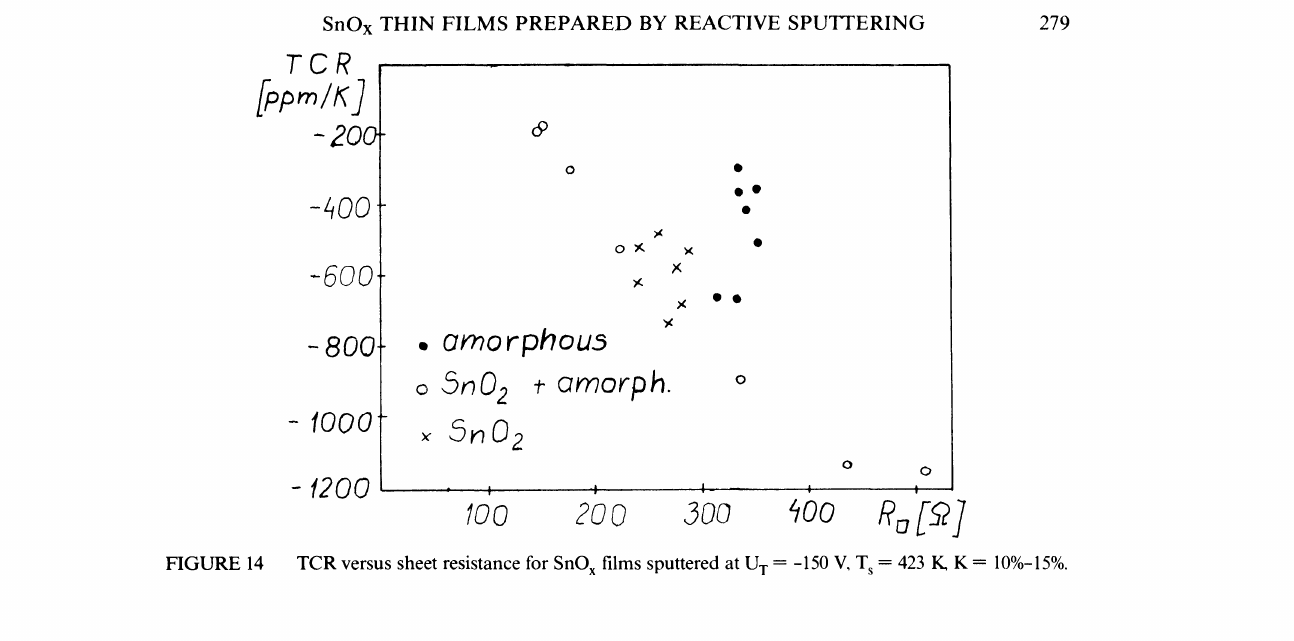
FIGURE 14 TCR versus sheet resistance for SnO films sputtered at U T -150 V, T 423 K, K